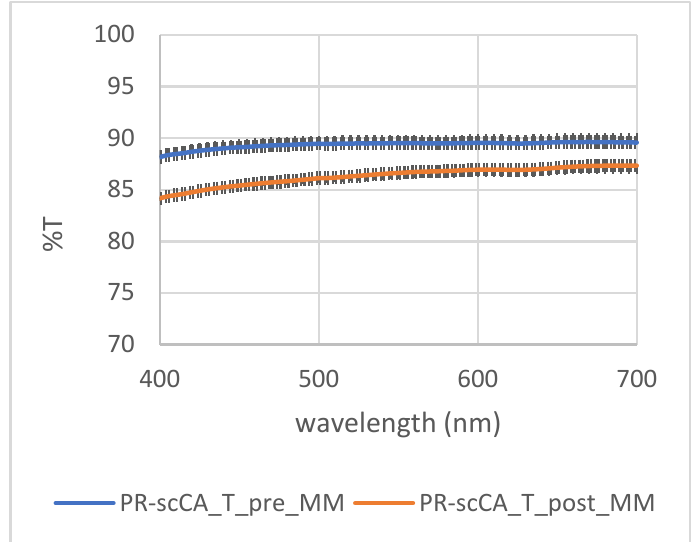
Figure 6. Comparison of transmittance values of the Scheu CA Pro + with Prodways LD20.printer before and after aging. The curves are the average of nine spectrophotometry measurements ± SD. Transparency decreased after aging even with Carbon L1 and RapidShape D100+ printers and Scheu CA Pro+ material. (Figures 7 and 8).